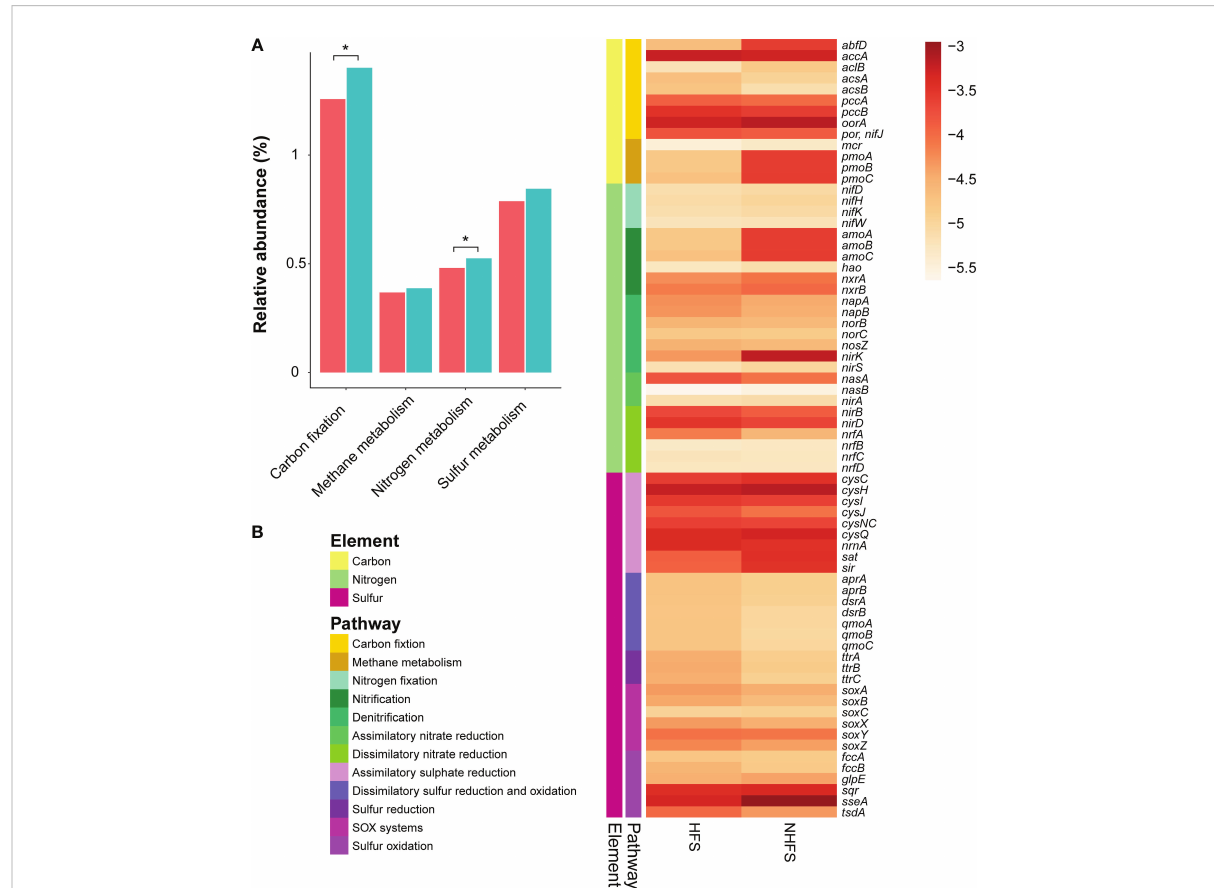
FIGURE 6 The relative abundance of element metabolism pathways and related genes involved in energy metabolism in HFSs and NHFSs based on KEGG orthologous gene identi fi cation by PICRUSt2 analysis. (A) Comparison of the relative abundance of carbon, nitrogen, and sulfur metabolism pathways between the two habitats. The red and blue colors indicate HFSs and NHFSs, respectively.*, P < 0.05 by Welch ’ s t-test. (B) Heat map showing the distribution of representative genes involved in energy metabolism in the two habitats. The color bar indicates the logarithm of relative abundance of the genes. SOX systems, sulfur oxidizing protein